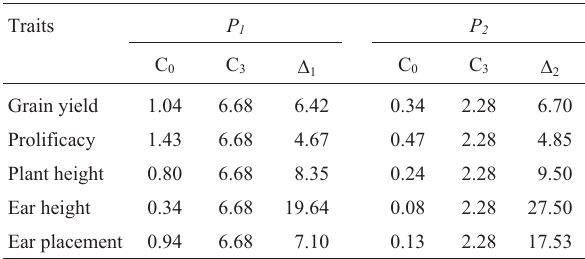
Table 4 - Probabilities (%) of double-crosses superior than the mean of cycle three plus one and half times ( P 1 ) and plus twice ( P 2 ) the phenotypic standard deviation for the original (C 0 ) and after three cycles (C 3 ) of reciprocal recurrent selection, and the ratios (cid:8) = ( P C3 /P C0 ).